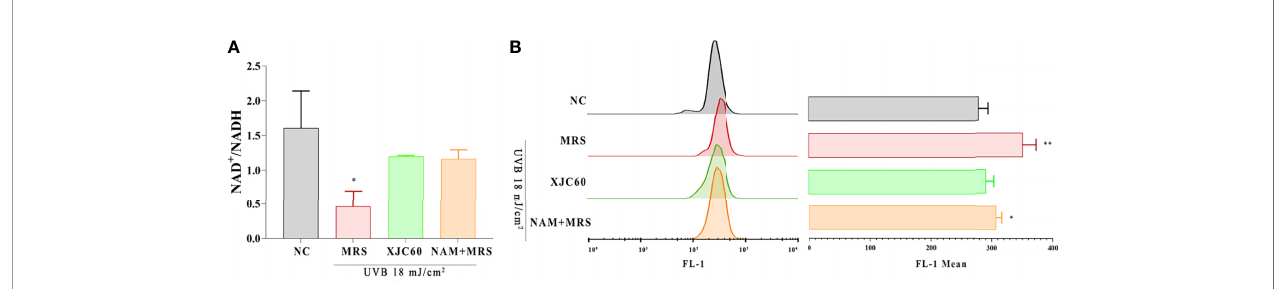
FIGURE 4 | Evaluation of mitochondrial protection by Limosilactobacillus fermentum -derived nicotinamide (NAM). (A) Effects of minimum nontoxic dilutions (MNTDs) on the NAD + /NADH ratio in L. fermentum XJC60 and equal amounts of NAM on UVB-injured HaCaT cells. (B) Flow cytometric analysis of JC-1 levels with different MNTDs in LAB. Data are presented as means ± SDs (n = 3). * P < 0.05, ** P < 0.01 compared with the